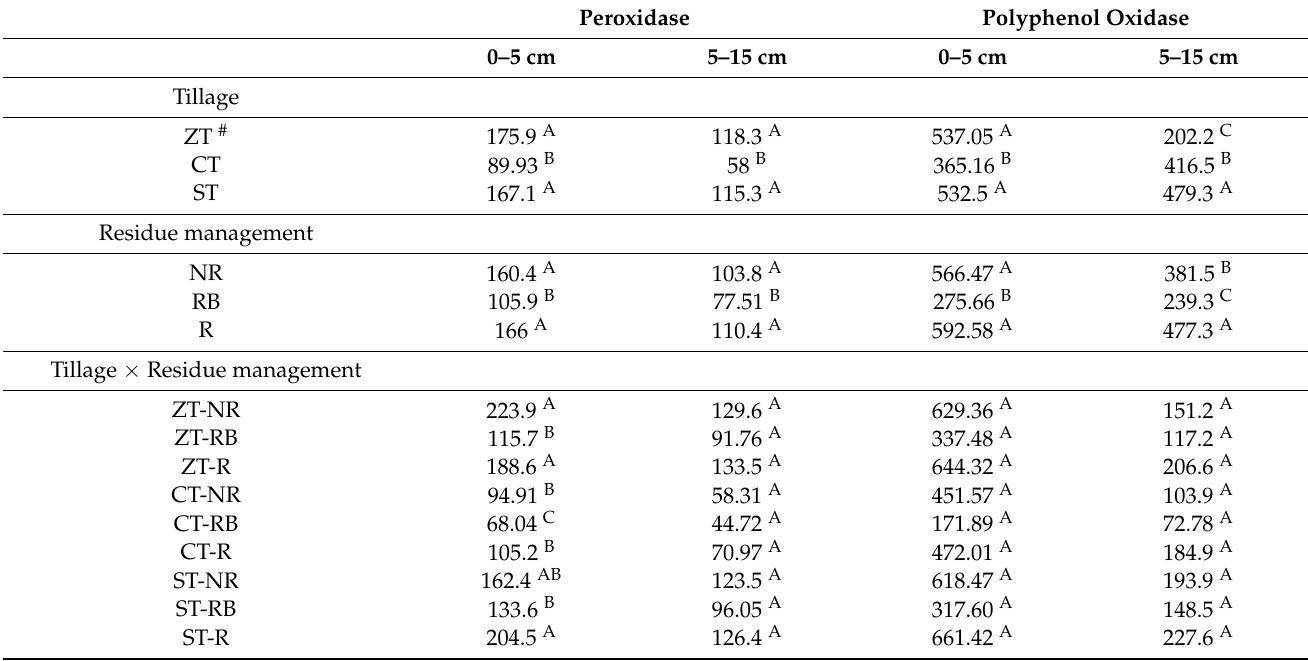
Table 5. Soil peroxidase and polyphenol oxidase activities ( µ g g − 1 h − 1 ) as influenced by 18 years of tillage and residue management under a rice–wheat cropping system in an Inceptisol in 0–5 cm and 5–15 cm